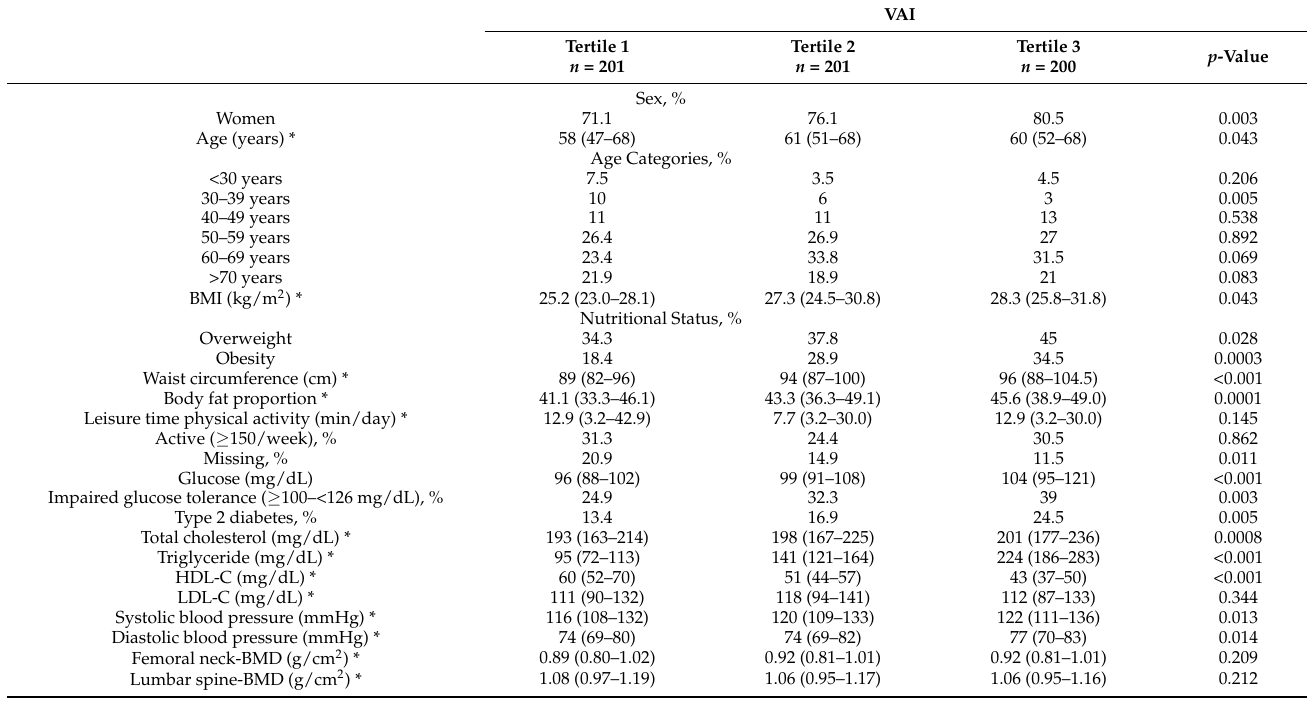
Table 2. Demographics classified by tertiles of the visceral adiposity index.